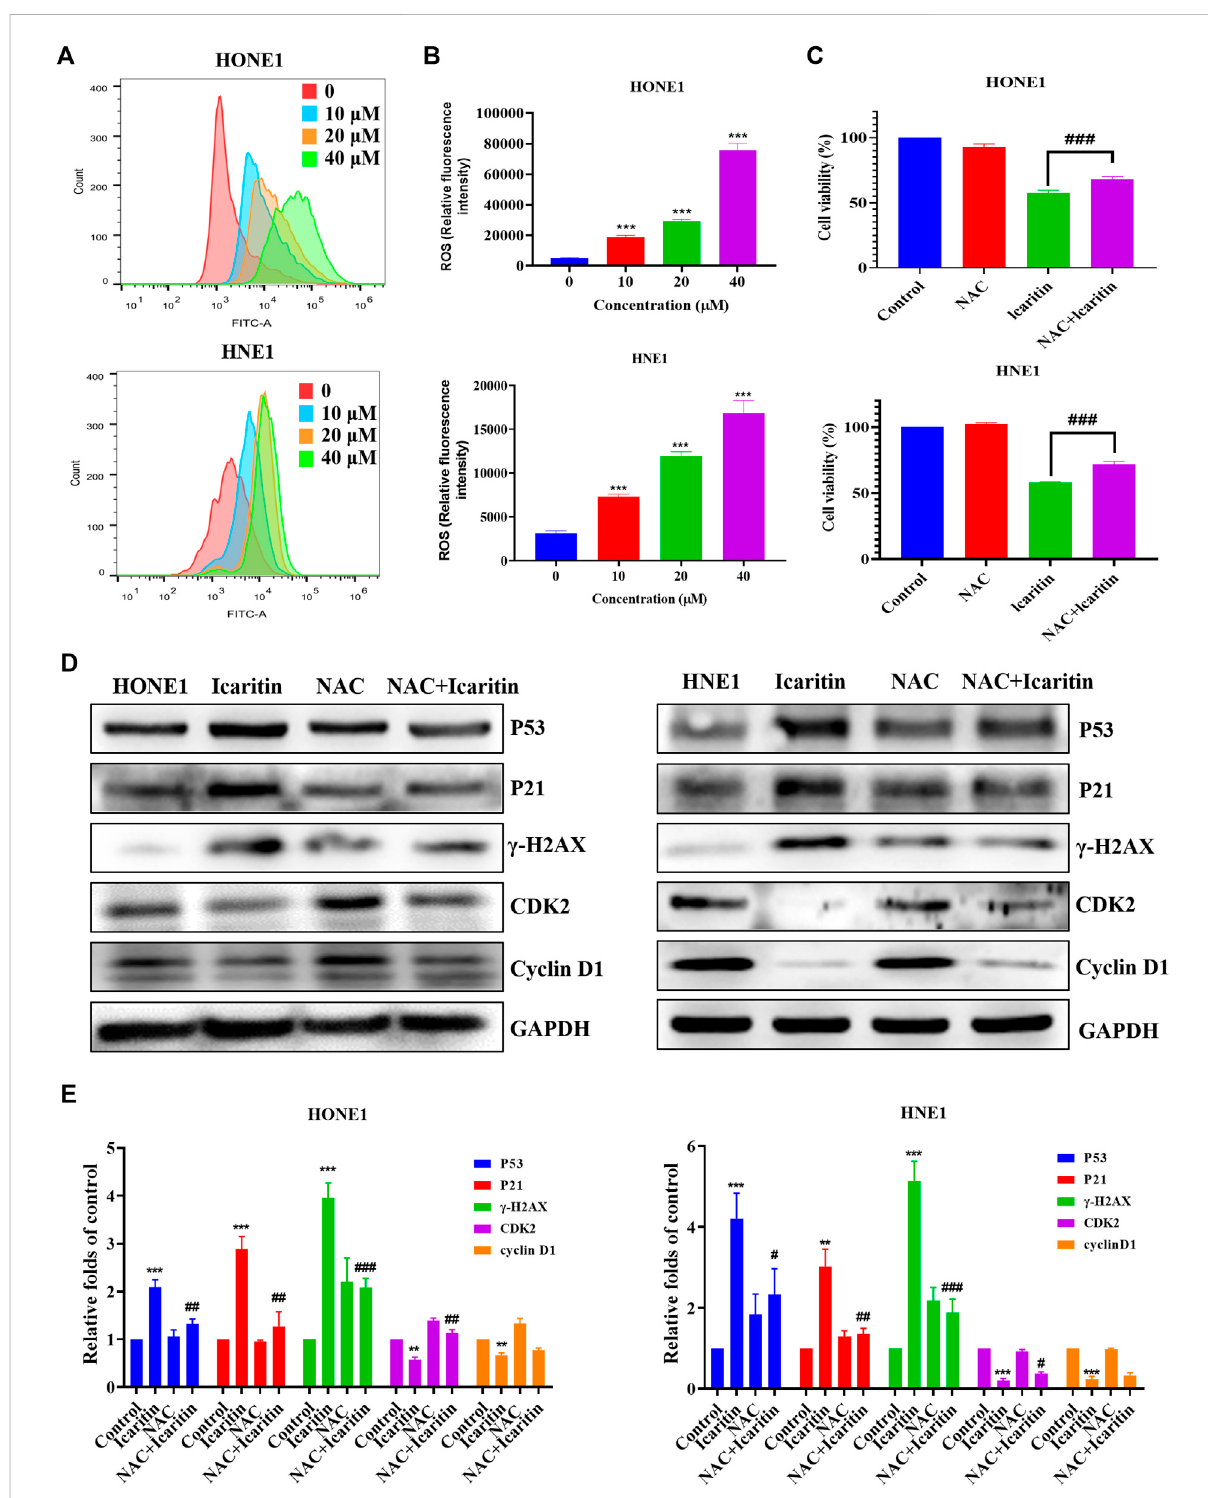
FIGURE 7 EffectoficaritinonthegenerationofROS. (A) TheROSlevelsinicaritin-treatedHONE1andHNE1cellswereassessedusingDCFbiomarkersand analyzedusing fl owcytometry. (B) StatisticalanalysisofROSlevelineachgroup. (C) Cellviabilityaftertreatmentwithicaritin(20 μ M),NAC(5 mM),or acombinationoficaritin andNAC for24 handdeterminedusingtheMTT assay. (D) Theexpression ofthecellcycleand senescence-relatedprotein in HONE1 and HNE1 cells was detected by western blotting after treatment with icaritin (20 μ M), NAC (5 mM) or a combination of icaritin with NAC for 24 h. (E) The quantitative analysis of proteinbands.** p < 0.01,*** p < 0.001 versus control; # p < 0.05, ## p < 0.01, ### p < 0.001 versus